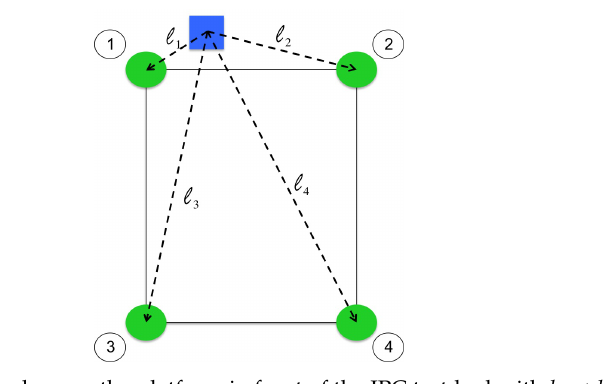
Figure 6. Pattern of markers on the platform in front of the IPC test-bed with l 1 < l 2 < l 3 < l 4